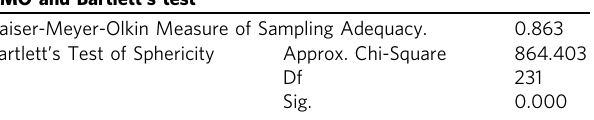
Table 2 The KMO and Bartlett ’ s test of sphericity of input QA for teaching and learning constructs.